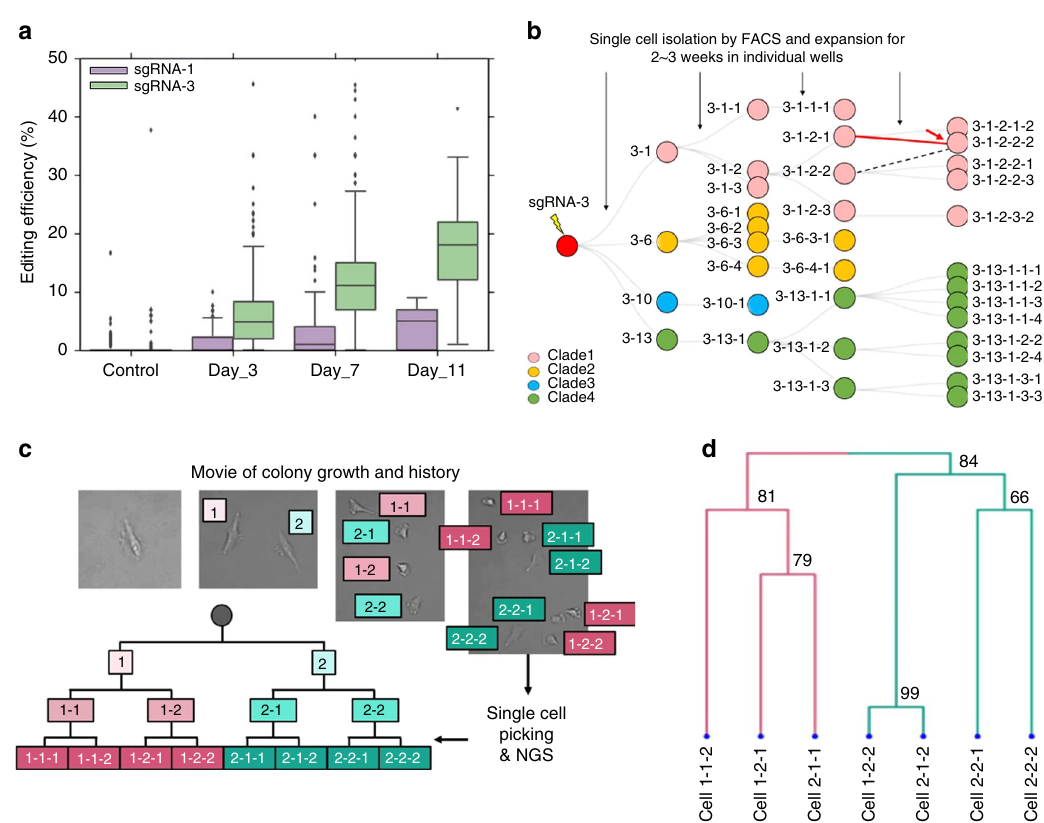
Fig. 2 Cumulative editing and analysis of lineage tracing experiment. a Cumulative editing ef fi ciency in the target regions using sgRNA-1 and sgRNA-3 for the de fi ned time points. b A representation of the tree experiment for sgRNA-3 in HEK293T cells. The single-cells were sorted and expanded to a limited number of cell divisions. The bulk cells were then ampli fi ed from a 96-well plate and sequenced for cell lineage analysis. A network graph 7 was constructed from all the pairwise cell barcode information. The “ − ” represents the mother-child node relationship and the colors of each circle represent the different clade (pink: Clade1, yellow: Clade2, blue: Clade3, green: Clade4). The misplaced nodes are represented by a red arrow. The red solid line connects the incorrectly placed mother-daughter node, and the dotted line indicates the correct mother-daughter node connection. c Time-lapse imaging of the single- cell expansion experiment. At the end of the video, single-cells were picked and sequenced for lineage reconstruction. d An example of a tree expansion experiment for seven single-cells. The bootstrapped con fi dence score (bootstrapped P -values × 100, n = 1000) are shown at the branching point. Physical isolation was impossible for the left most cell (1 – 1 – 1) in ( c ). The source data are available in the Source Data fi